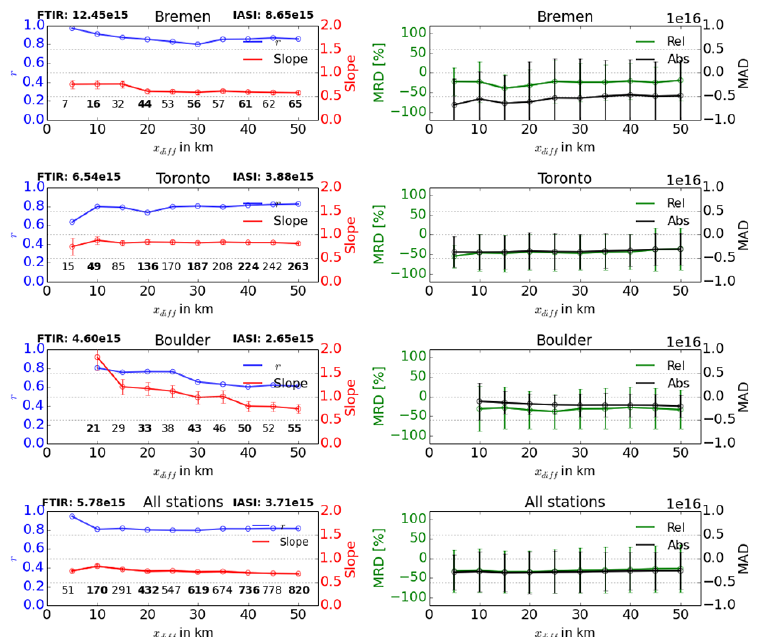
Figure 3. Correlation r (blue lines, left figures), slope (red lines, left figures) regression results, mean relative difference (MRD, green lines, right figures) and mean absolute difference (MAD, black lines, right figures) between IASI and FTIR observations as a function of x diff for a selection of sites. Bars indicate the standard deviation of the slope of the individual regression results. The numbers in the bottom of each subfigure show the number of matching observations. The numbers on the left and right side of the stations name give the mean FTIR and IASI total columns for an x diff <